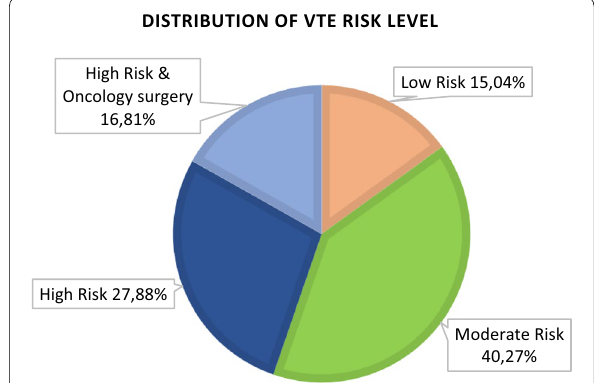
Fig. 3 Risk level for VTE within the sample